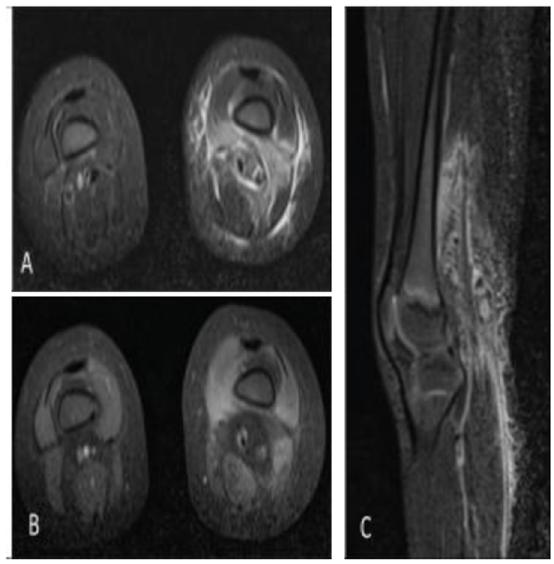
Figure 1. Axial ( A ) and sagittal ( C ) Short-TI Inversion Recovery (STIR) magnetic resonance imaging (MRI) images of the bilateral lower extremities demonstrate edematous signal involving the left lower extremity vastus medialis, vastus intermedius, soft tissues of the popliteal fossa, and overlying subcutaneous soft tissues. Axial fat-saturated T1-weighted postcontrast MRI of the bilateral lower extremities ( B ) demonstrates associated enhancement of the vastus medialis, vastus intermedius, and soft tissues of the popliteal fossa. Findings are compatible with myositis with overlying